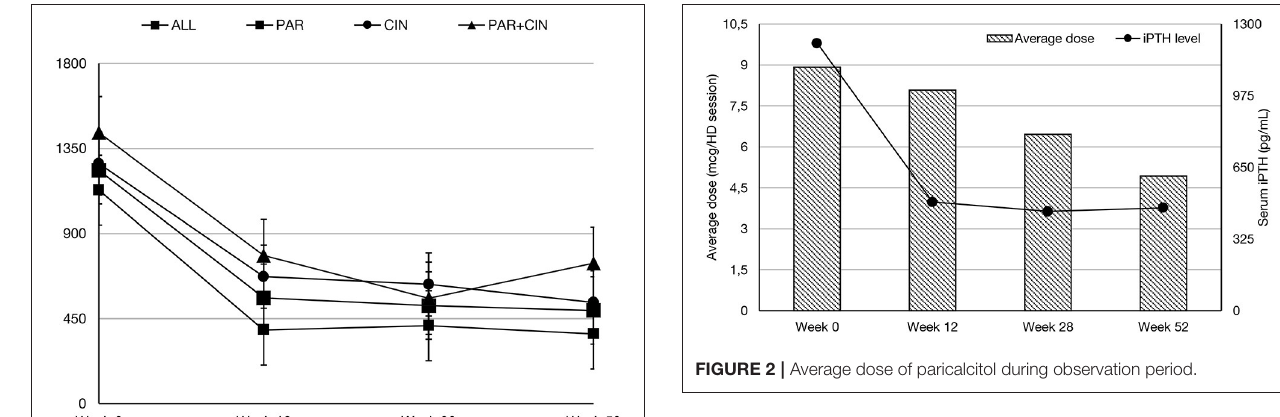
of calcium—based phosphate binders or non-calcium based phosphate binders as shown in Table 1 . The dialysis was provided on Fresenius 5008S HD machines with FX Cordiax dialysers.